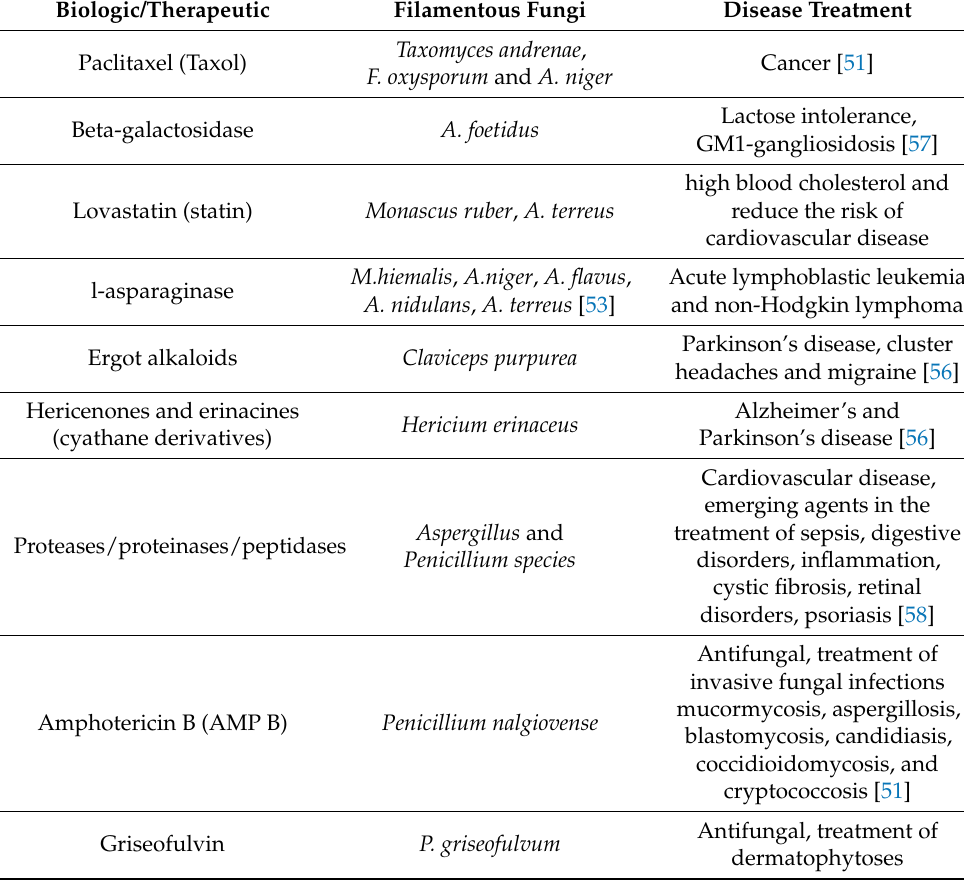
Table 3. Biologically active compounds produced by filamentous